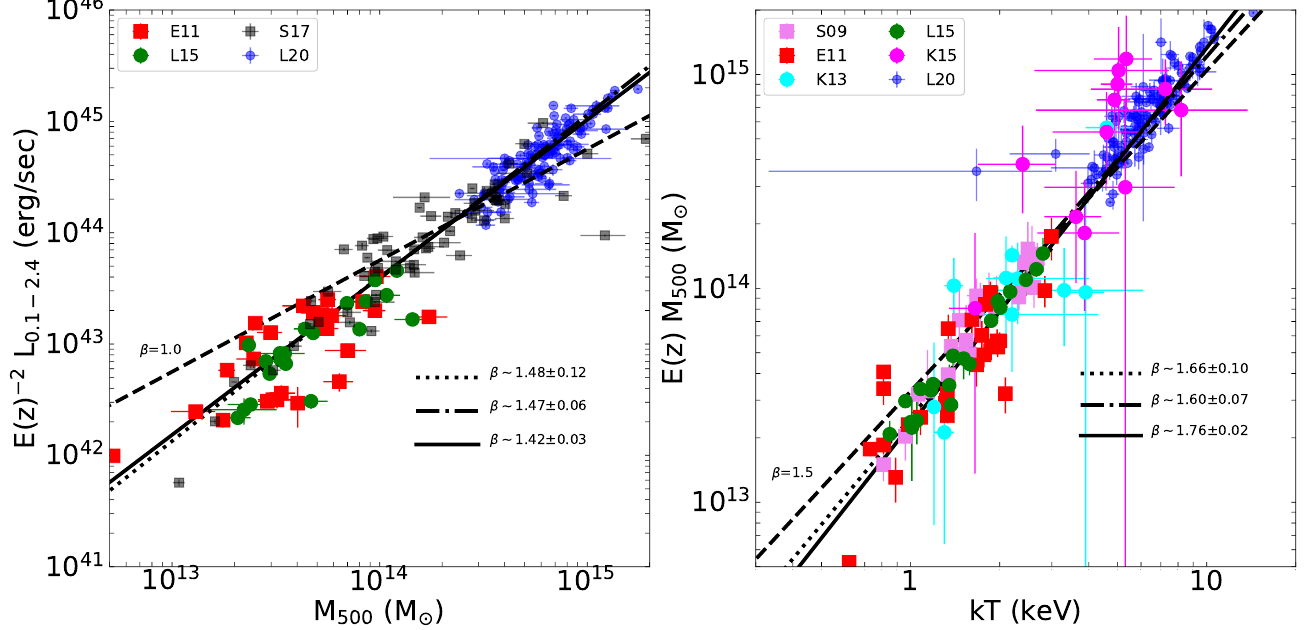
Figure 4. XMM–Newton (circles) and Chandra (squares) measurements of the L 0.1 − 2.4 –M ( left panel ) and M–T x ( right panel ) relations for different samples of groups: (Eckmiller et al. [96], E11), (Lovisari et al. [77], L15), (Sun et al. [81], S09), (Kettula et al. [113], K13). The groups measurements are compared with the ones from an X-ray-selected (Schellenberger and Reiprich [100], S17) and an SZ-selected (Lovisari et al. [34], L20) cluster sample. Luminosities and masses are all within R 500 while temperatures are obtained in different regions (see Table 2). Please note that different studies used different methods to estimate the total masses. The lines represent the fitted relation for M < 10 14 M (cid:12) systems (dotted), M > 10 14 M (cid:12) systems (dashed-dotted), all systems (solid), and are compared with the case predicted by the self-similar scenario (dashed). Because of the strong covariance between M and T x we did not convert the Chandra temperatures to XMM–Newton -like